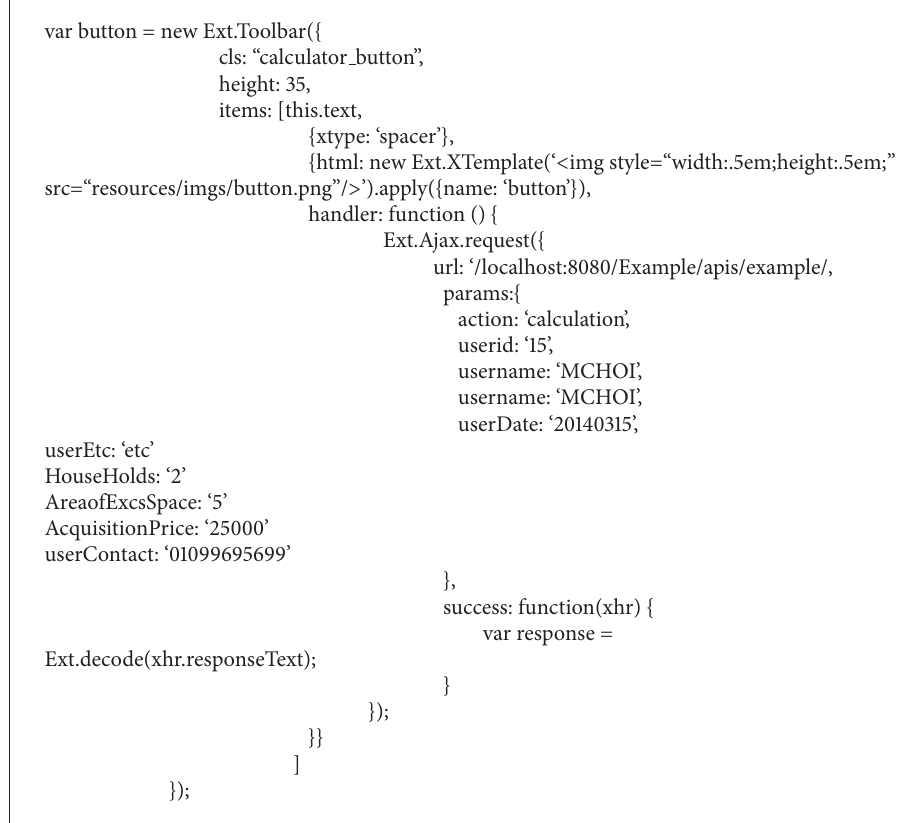
Algorithm 2: A portion of our HTML5 application